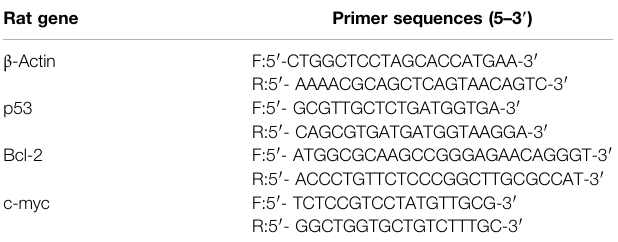
TABLE 1 | Gene-speci fi c